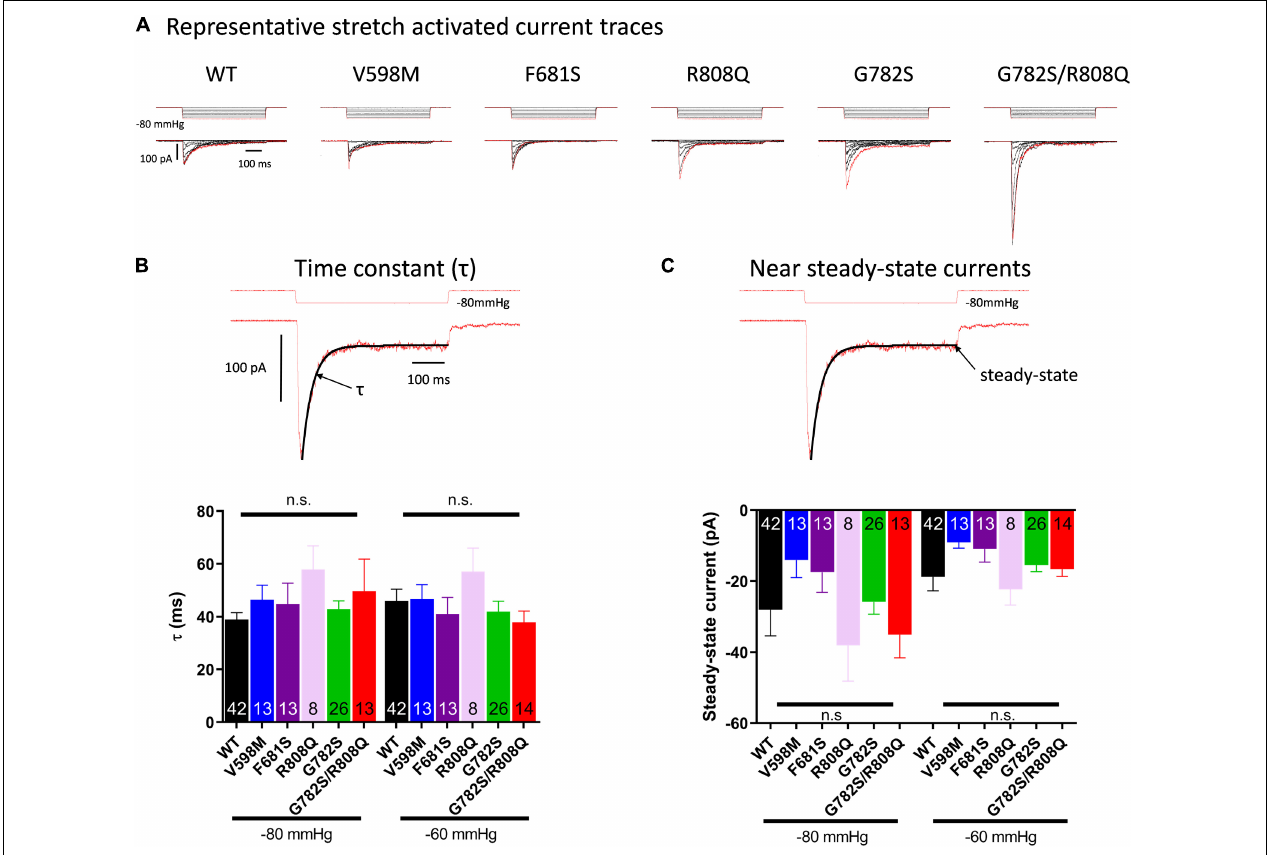
FIGURE 3 | (A) Representative traces of currents induced by stepwise negative pipette pressure (0 to − 80 mmHg, (cid:49) 10 mmHg) recorded in HEK293T cells expressing WT and mutants. Stretch-activated currents of PIEZO1 WT and mutants-expressing HEK293T cells recorded in cell-attached configuration. (B) Inactivation time constant ( τ ) of currents from PIEZO1 WT and mutants. The top trace shows a representative current fitted by an exponential decay at − 60 and − 80 mmHg. τ is obtained from the fit. (C) Near steady-state currents from PIEZO1 WT and mutants. The steady-state current values were obtained from the fit at the end of the pressure pulse. Currents recorded in cell-attached